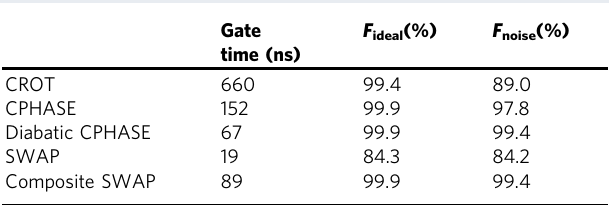
Table 1 Gate times and simulated fi delities for silicon qubits at T = 1.05